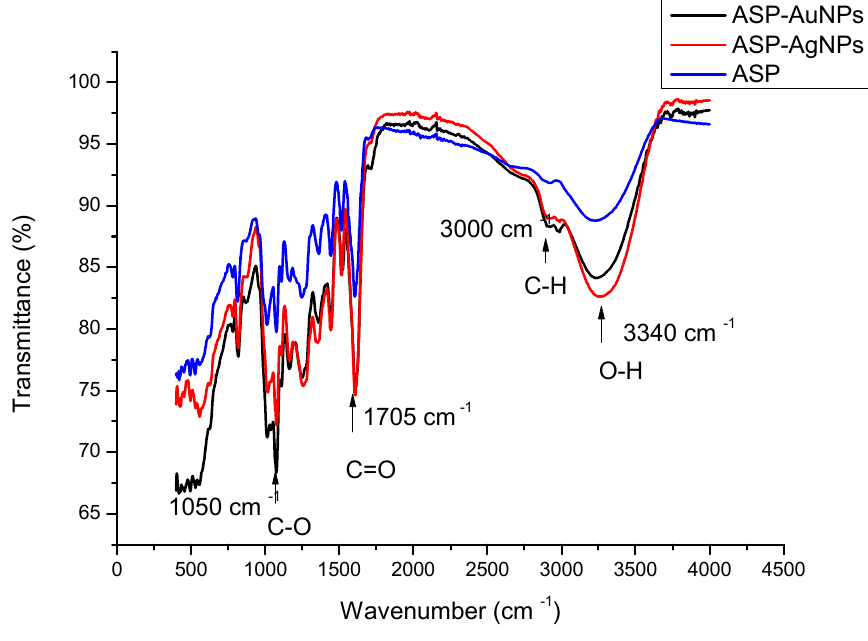
Figure 5. FTIR spectra of the ASP, ASP-AuNPs, and ASP-AgNPs.